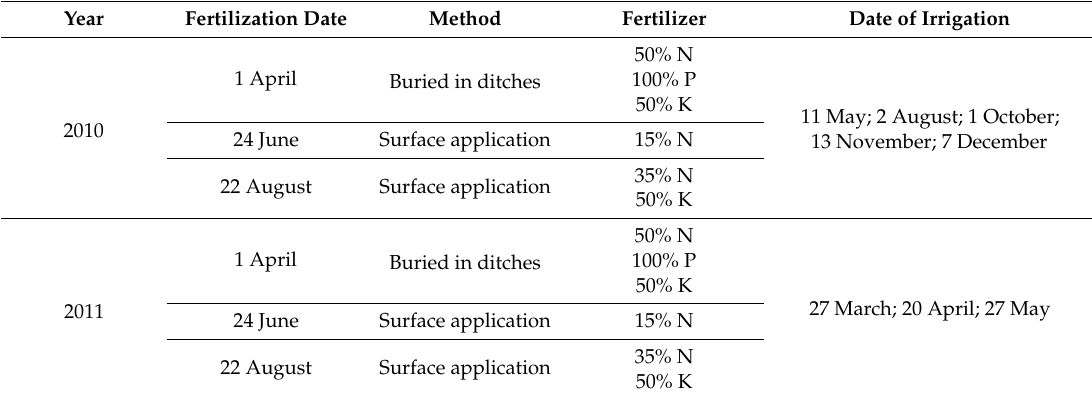
Table 2. Management practices in the apple orchard between 2010 and